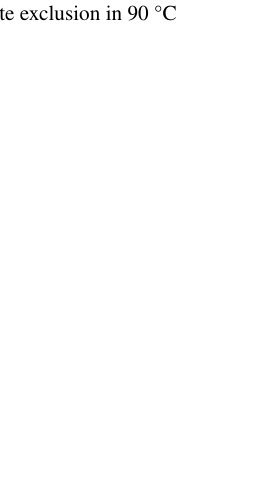
Fig. 11 Effect of calcium and sulfate exclusion in 90